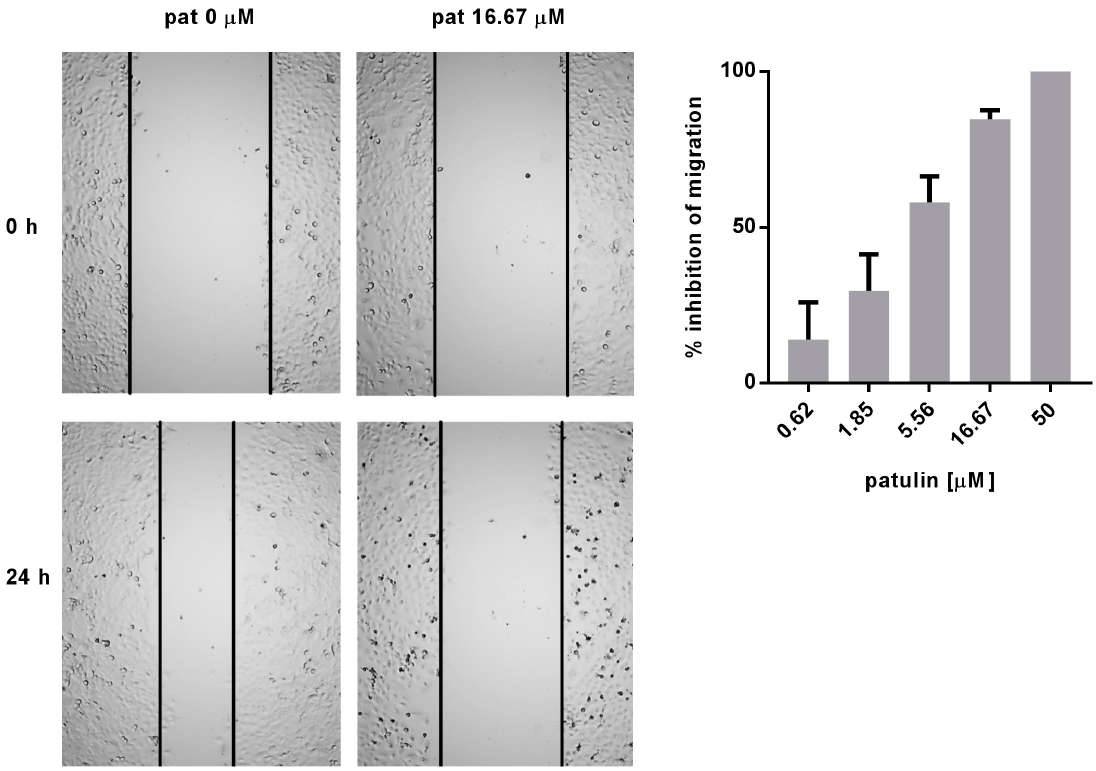
Figure 4 . Dose-dependent inhibition of A549 cells migration 24 h after patulin treatment, evaluated through the scratch assay. Time-lapse videos are available as supplementary material. Quantification of migration inhibition was performed on three independent experiments.